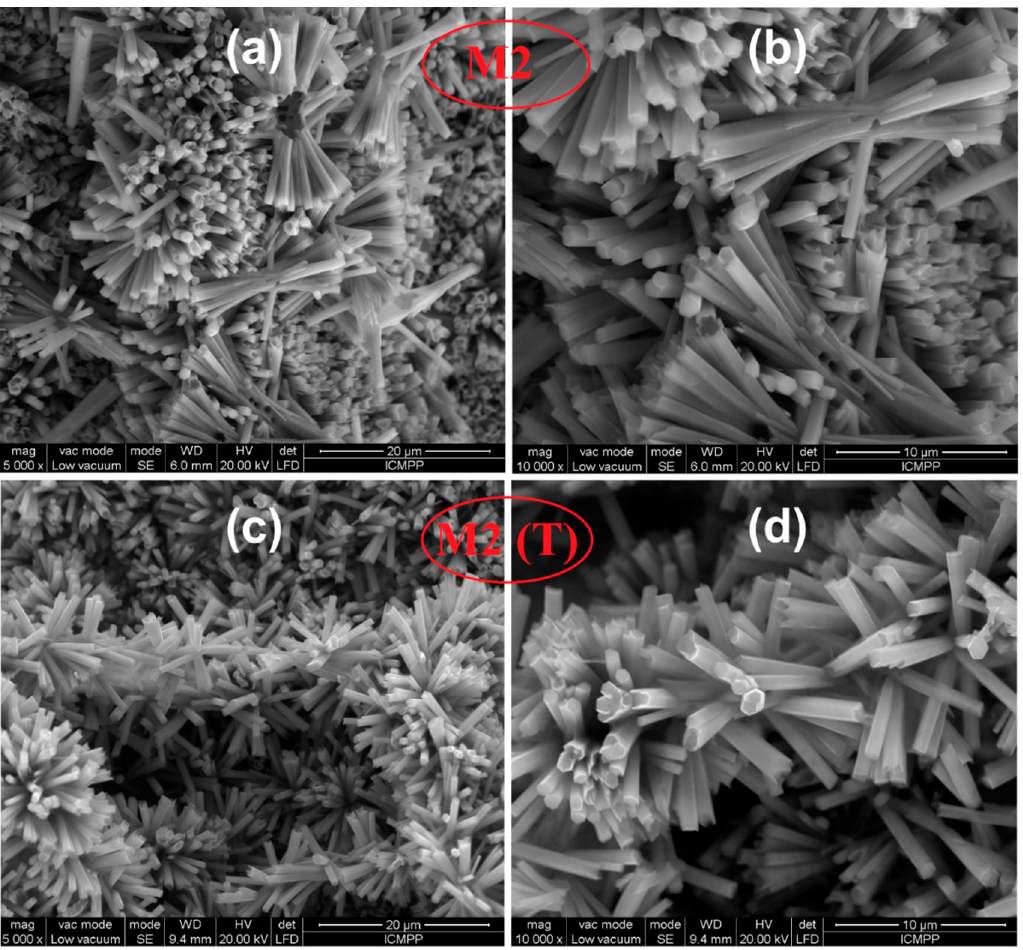
Figure 5. SEM analysis of CAB / ZnO hybrid nanostructures obtained by the hydrothermal method after thermal treating at 240 ◦ C in the air for 1 h (( a ) and ( b ) for M2 ), and carbon / ZnO after thermally treating at 600 ◦ C in N 2 for 30 min (( c ) and ( d ) for M2 (T) ).